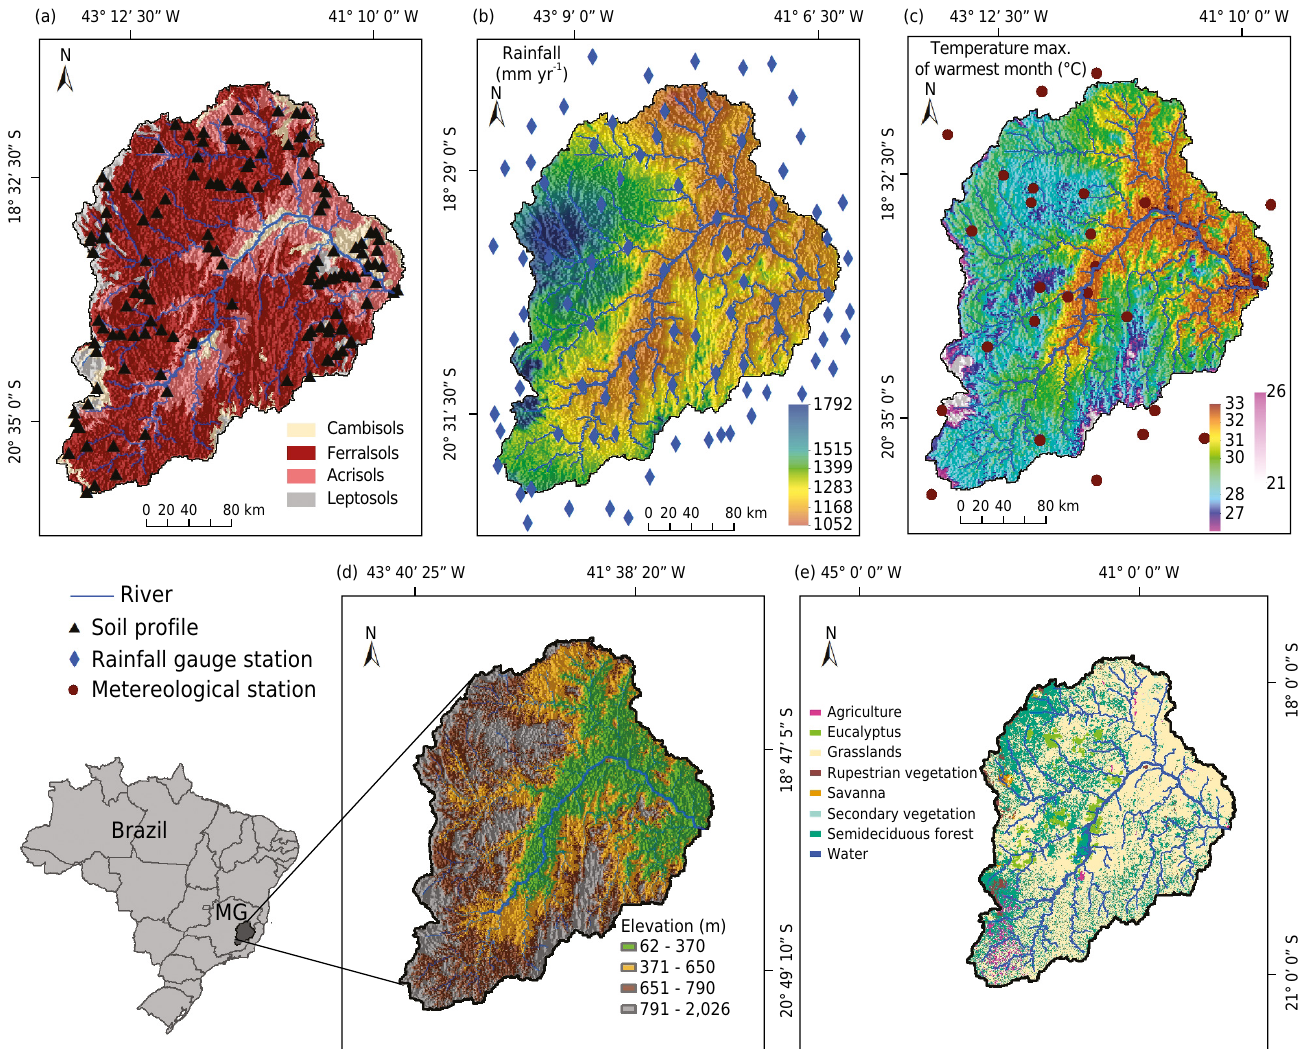
Figure 2. Location of the Doce River Basin in the state of Minas Gerais (MG), Brazil, and the thematic maps: (a) soil types and location of the soil profile used, (b) rainfall gauge stations, (c) meteorological gauge stations, (d) land coverage, and (e) elevation above sea